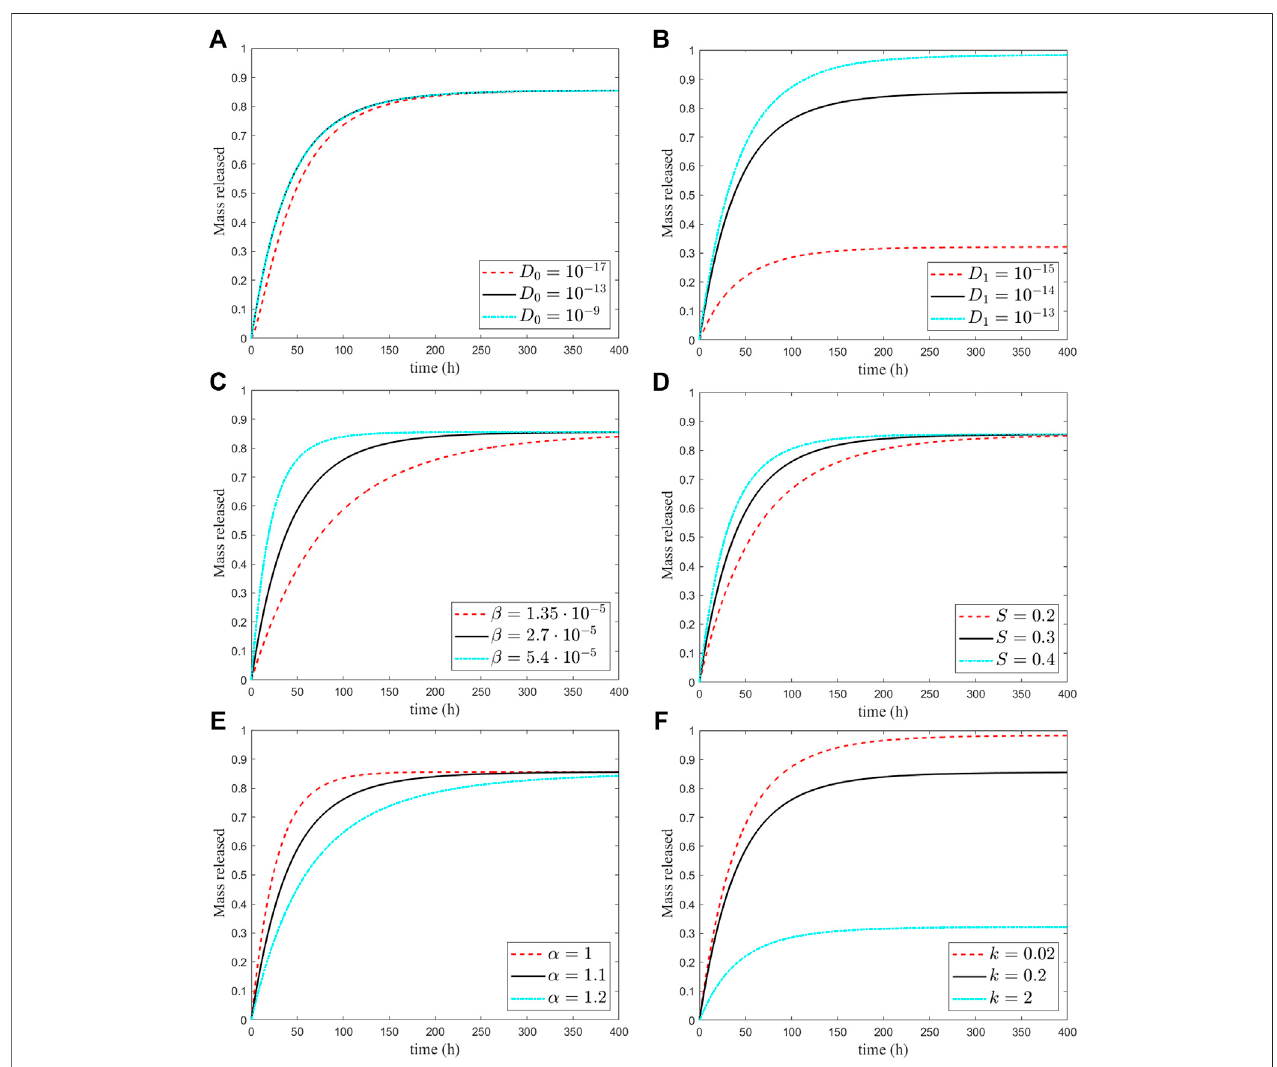
FIGURE 7 | Sensitivity of the release curves to the six model parameters varied with respect to their reference values in Table 1 . The black curve refers to the reference values, the red curve to a smaller value, and the blue to a greater value (cfr. tables 1.2).